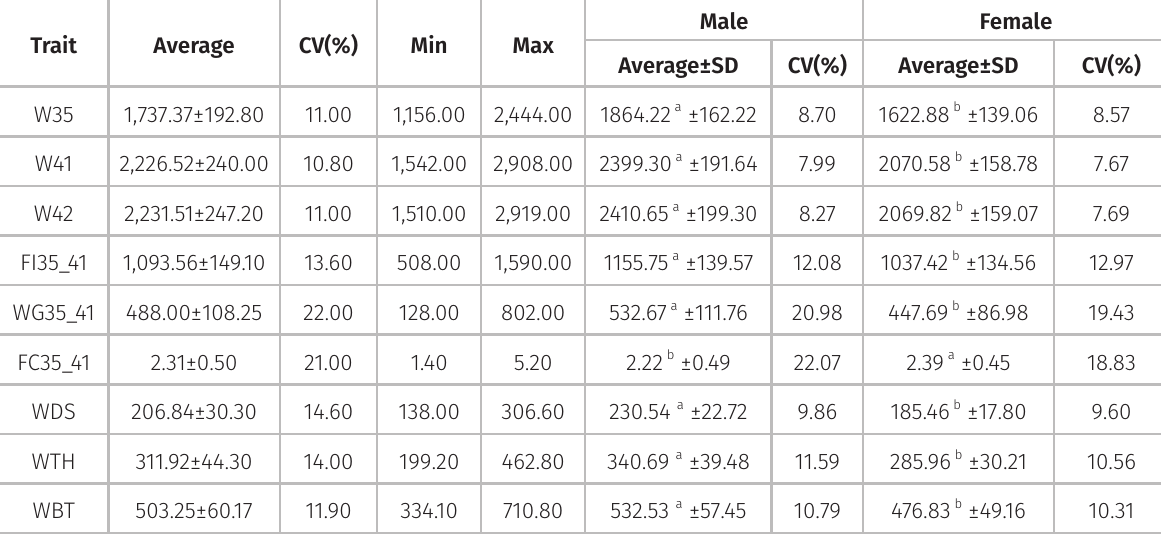
Table I. Average (in grams) ± standard deviations (SD) and coefficient of variations (CV%) for performance and carcass traits measured in a paternal broiler line.